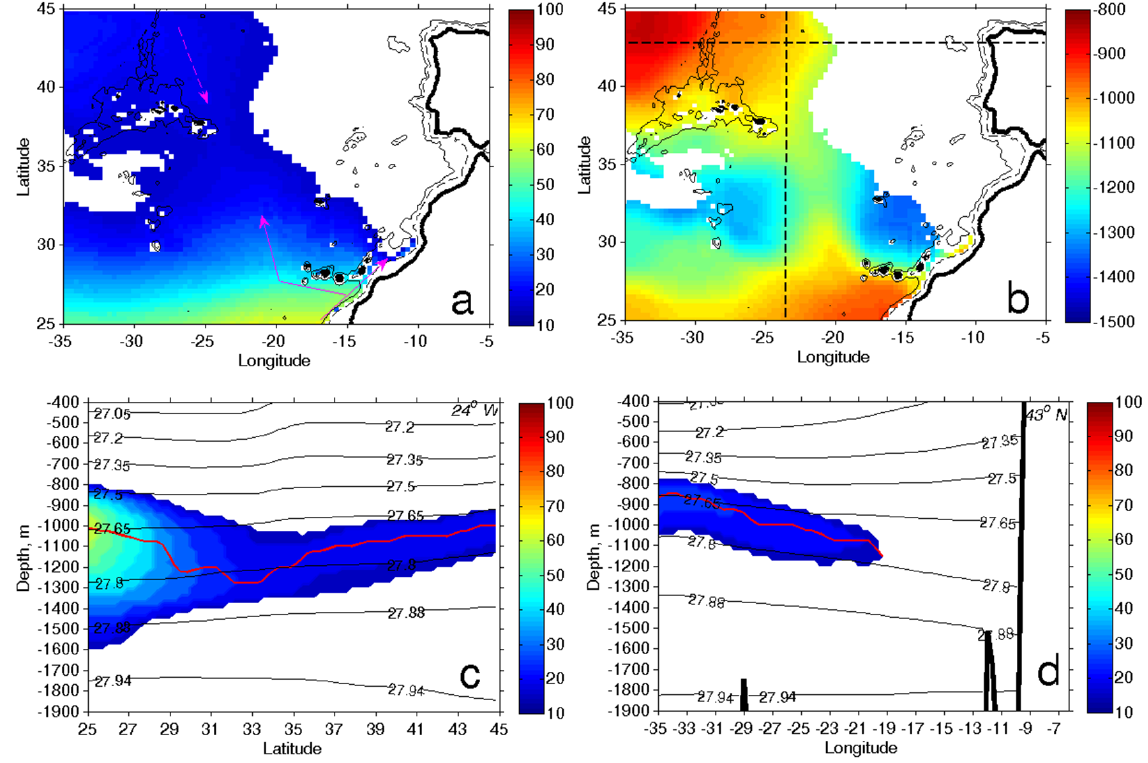
Figure 8. mAAIW: (a) maximum percentage in the water column, magenta lines mark suggested pathways of mAAIW (solid line), and modified mAAIW (dashed line); (b) depth (m) at which the maximum percentage in the water column is reached. Isobaths of 500 and 2000m are marked in dashed and solid black lines, respectively. Zonal and meridional sections, presented in panels (c) and (d) , are marked with dashed black lines. (c) meridional section of the mAAIW content (%) along 24 ◦ W; (d) zonal section of the mAAIW content (%) along 43 ◦ N. Red line marks the depth of the maximum content of the source water type in the water